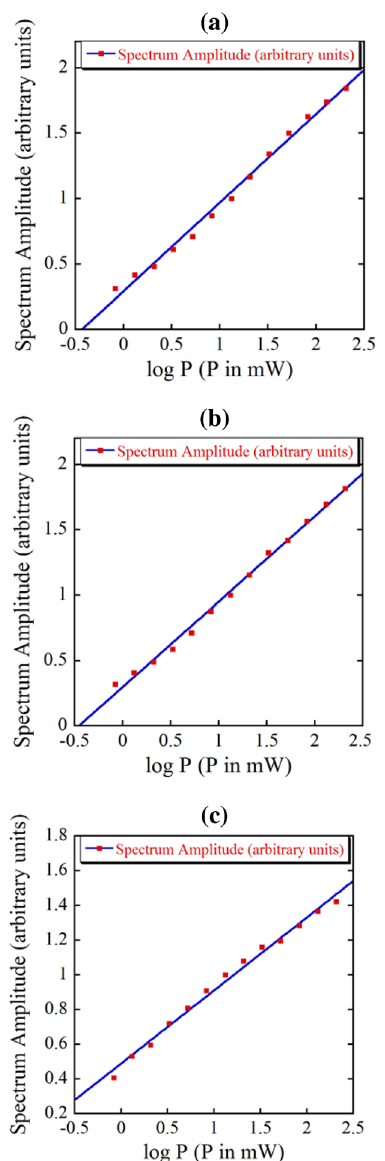
Fig. 4 Spectrum amplitude as a function of microwave power for a the parent, b inertinite-rich, and c vitrinite-rich samples. The exponents for each of the power law fits are a 0.68 ± 0.02, b 0.65 ± 0.01, and c 0.42 ±